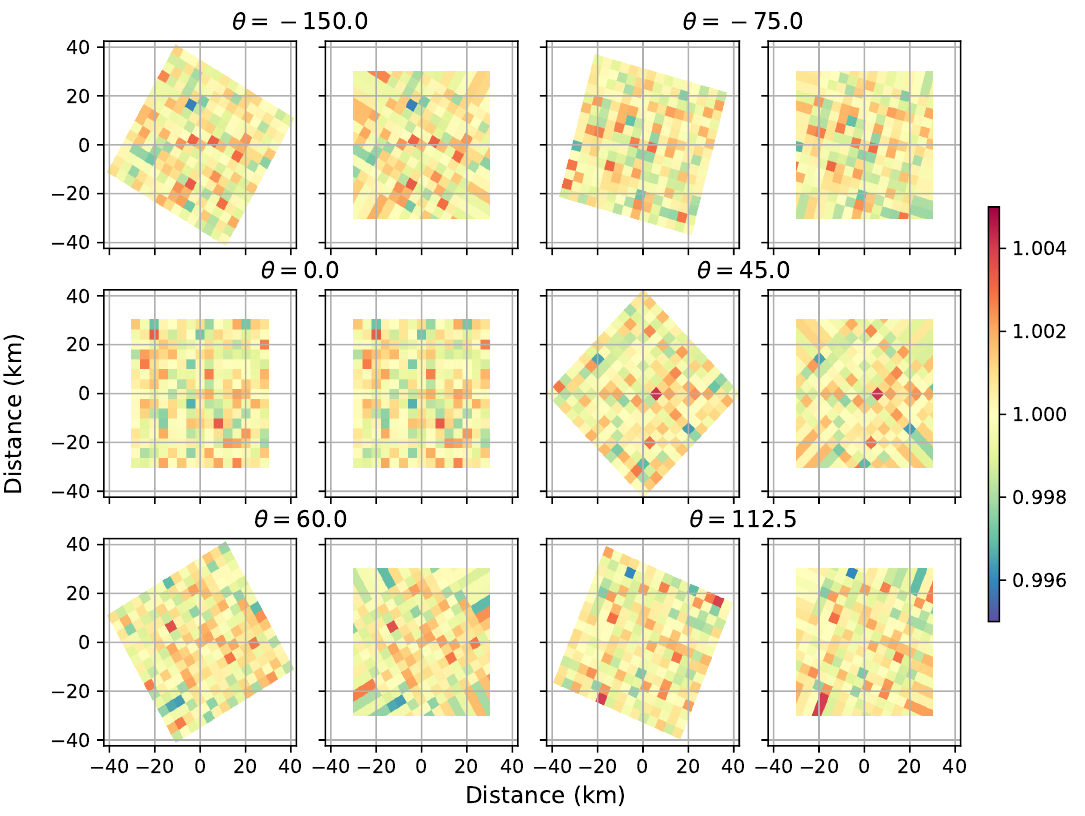
Figure 11. Simulated images of XCO 2 relative to a 400 ppm background as in Figure 4, for a 6 Mt yr − 1 source.